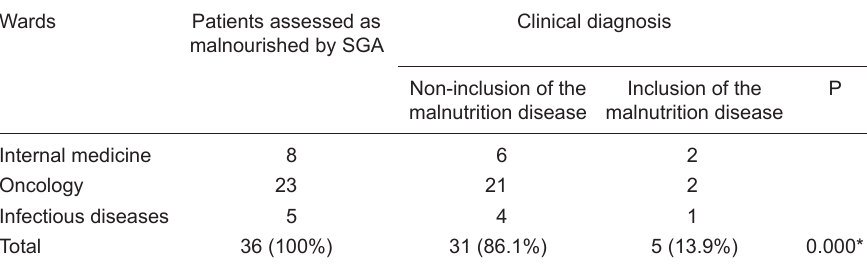
Table 2. Inclusion of malnutrition in the clinical diagnoses of the records of patients according to the hospitalization ward at the Hospital de Clínicas, Universidade Federal de Uberlândia. Wards Patients assessed as malnourished by SGA